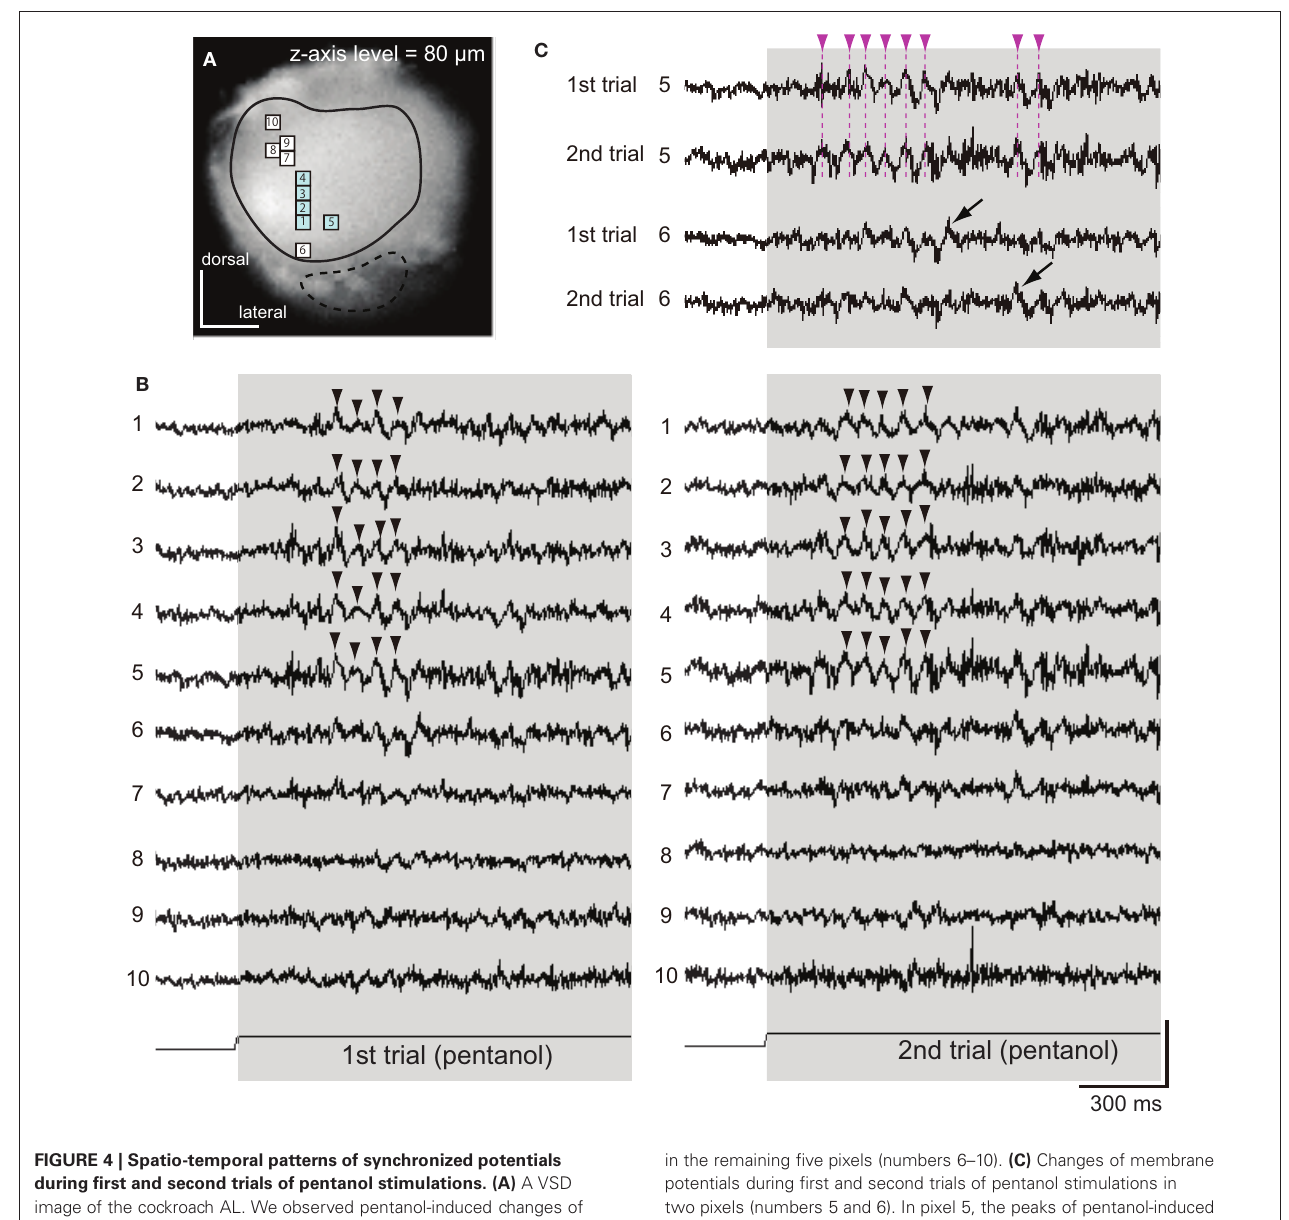
FIGURE 4 | Spatio-temporal patterns of synchronized potentials during first and second trials of pentanol stimulations. (A) A VSD image of the cockroach AL. We observed pentanol-induced changes of membrane potentials in 10 pixels. Areas surrounded by solid and broken lines correspond to glomeruli of the antero-dorsal and postero-ventral groups, respectively. (B) Pentanol-induced changes of membrane potentials in 10 pixels shown on (A) . In both first (left) and second (right) trials, pentanol (shaded bar) generated synchronized potentials (arrow heads) in five pixels (numbers 1–5, blue pixels in A), but not